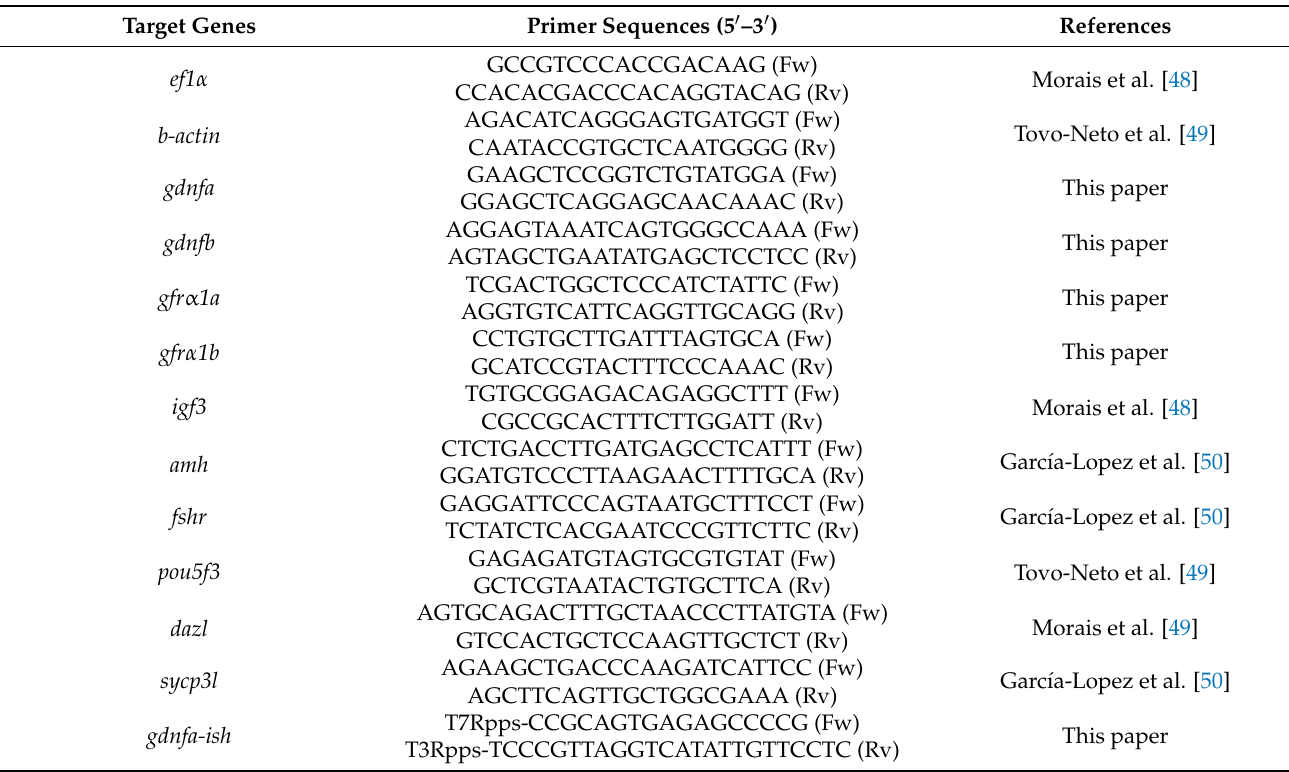
Table 1. Primers used for gene expression analysis (RT-qPCR) and to generate DNA templates for digoxigenin (DIG)-labeled cRNA probe synthesis for in situ hybridization (ISH) (Supplementary